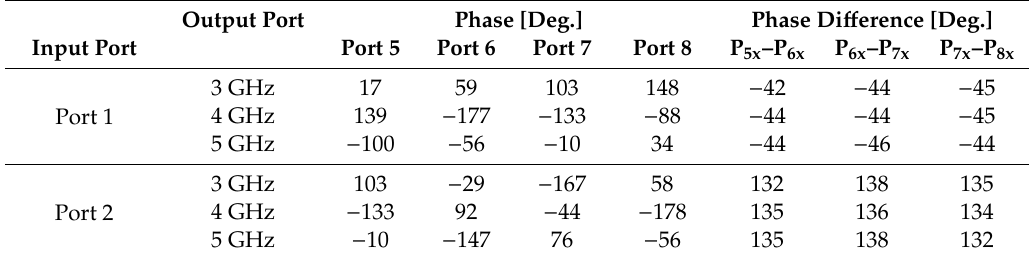
Figure 13. Simulation analysis of phase difference for input Port 1. Figure 14. Simulation analysis of phase for input Port 2.